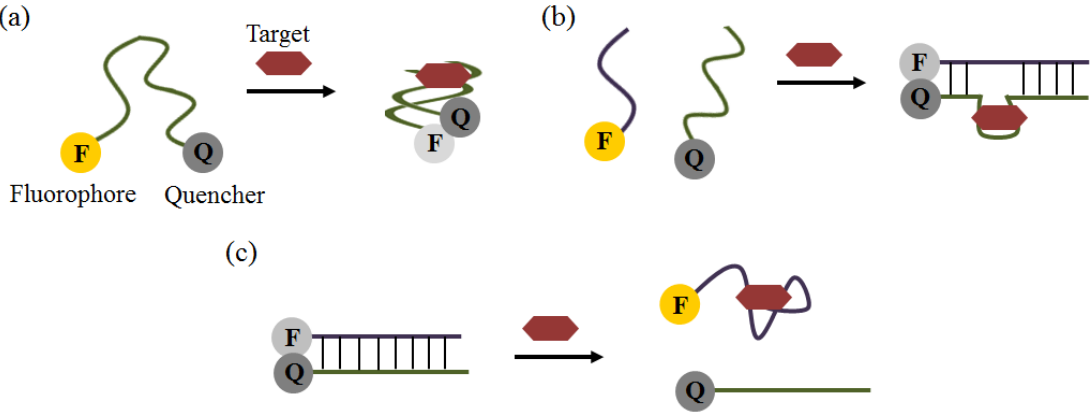
Figure 6. Schematic illustrations of optical aptasensors using fluorescence. ( a ) The simplest format of a quenching aptamer beacon. The binding of the target stabilizes the stem and brings the quencher and fluorophore in close proximity, resulting in fluorescence decrease; ( b ) Assembly aptamer beacon. The binding of the target brings the oligomers together and leads to ternary complex stabilization; ( c ) Disassembly aptamer beacon. The target binding induces an antisense displacement and results in a fluorescence